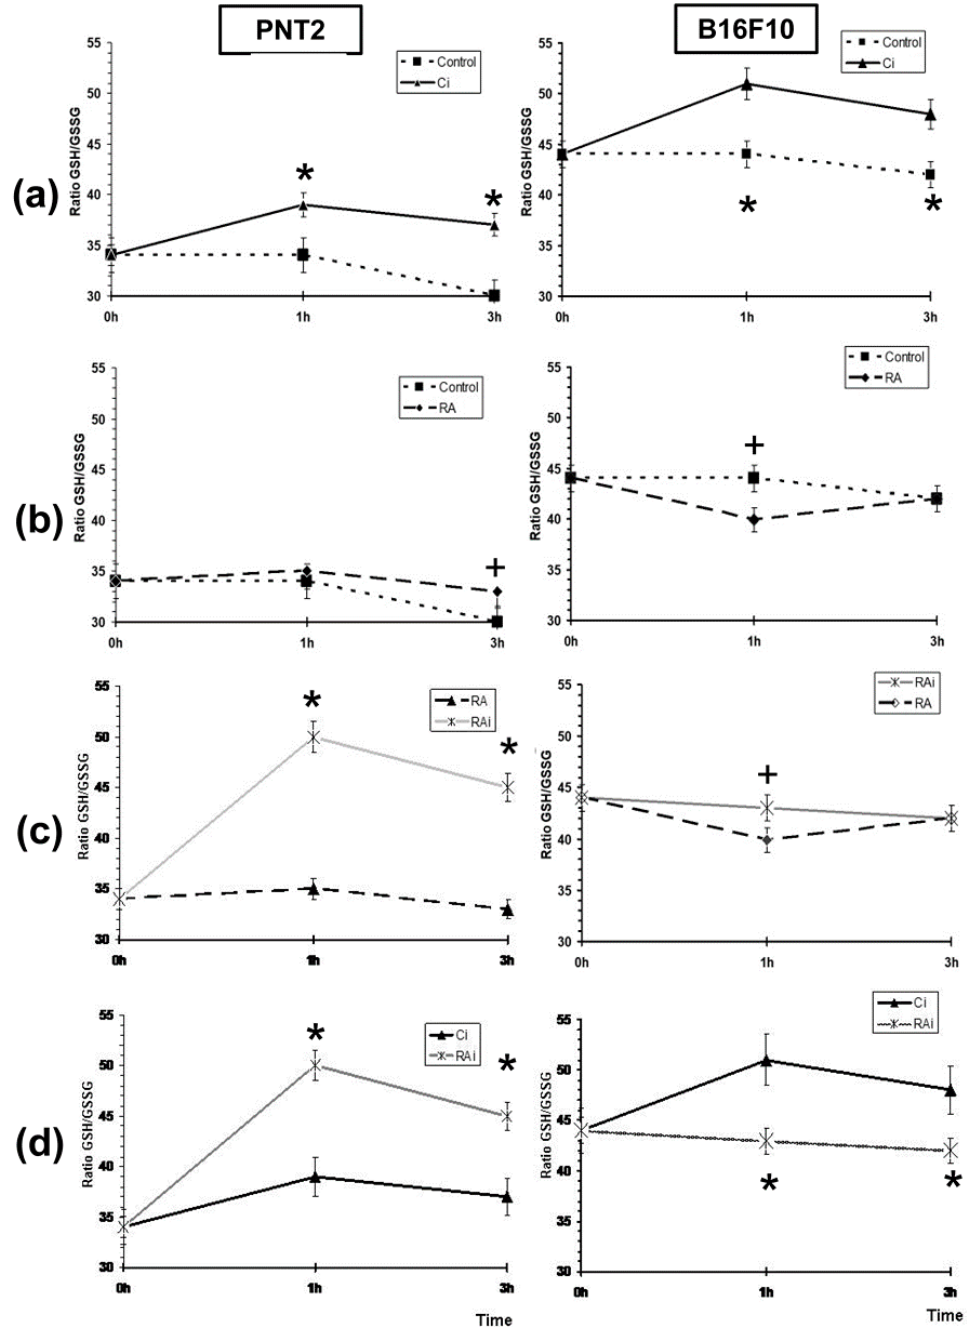
Figure 4. GSH / oxidized glutathione (GSSG) ratios in PNT2 and B16F10 cells determined at 1h and 3h after exposure to 20 Gy of X-rays: ( a ) GSH / GSSG ratio in unirradiated and in irradiated control cells; ( b ) GSH / GSSG ratio in unirradiated control cells and in RA-treated cells; ( c ) GSH / GSSG ratio in RA-treated cells and in irradiated RA-treated cells; ( d ) GSH / GSSG ratio in irradiated control cells and irradiated RA-treated cells (C—unirradiated controls, Ci—irradiated controls, RA—treated cells with RA dissolved in PBS, RAi—irradiated cells treated with RA dissolved in PBS, * p < 0.001, + p < 0.01). Data are the mean ± standard error of eight independent experiments.